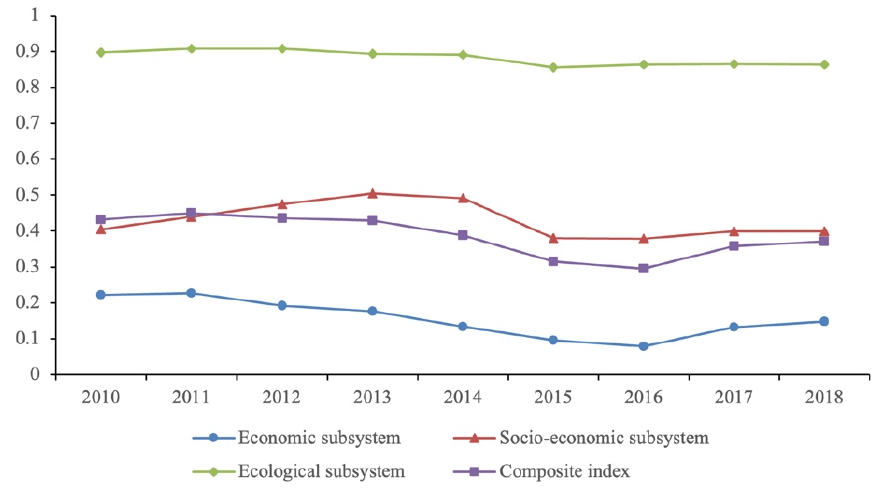
Figure 5. Dynamics of summary and composite indicators of the Republic of Buryatia for 2010–